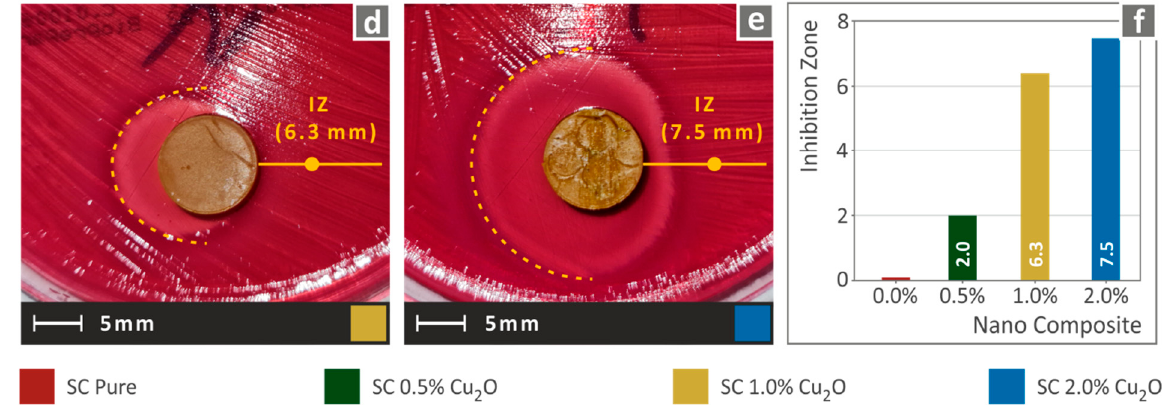
Figure 8. ( a ) typical E. Coli morphology, ( b – e ) Vertical captures after 24 h cultivation of tested specimen in a petri dish for each corresponding tested material, ( f ) Comparative graph of the measured inhibition zones to filler loading (wt.%).